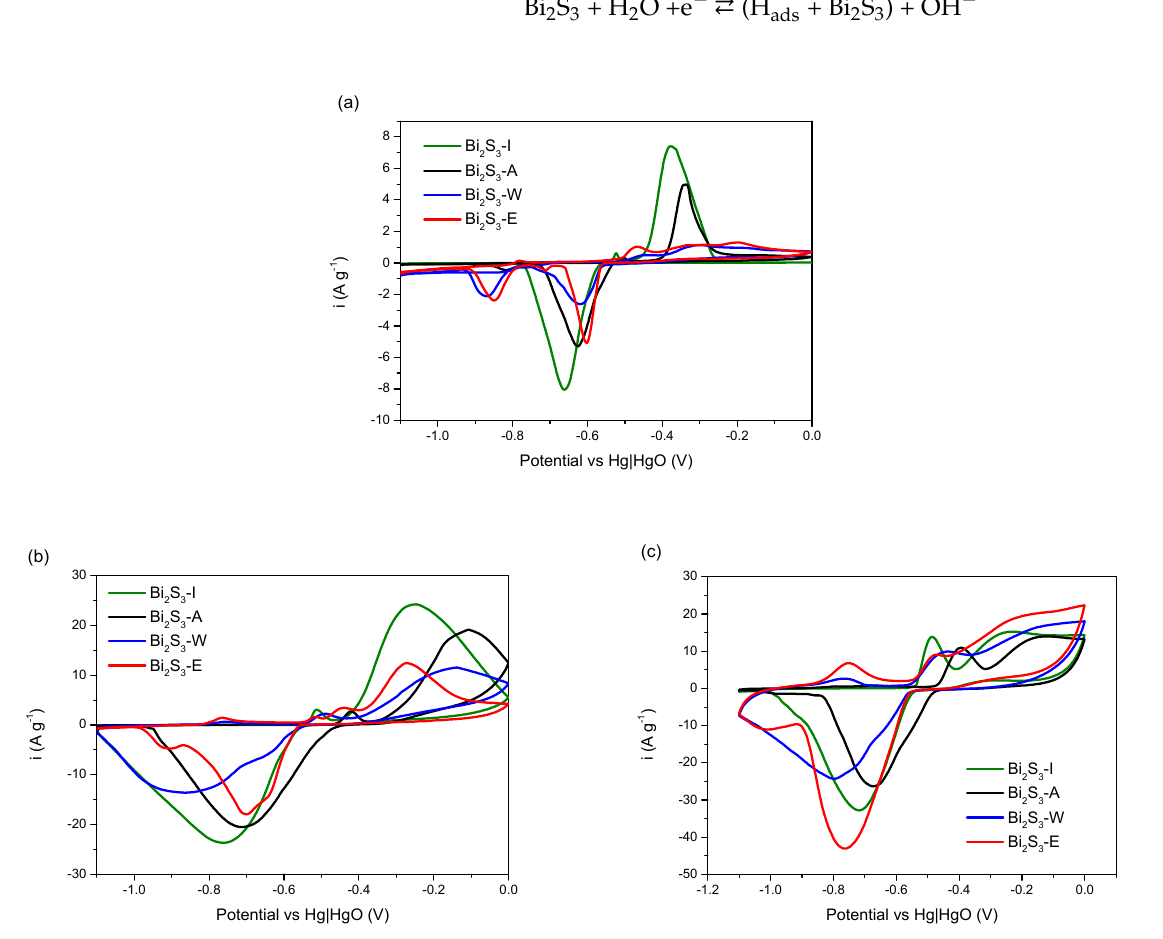
Figure 5. Cyclic voltammograms of the bismuth sulfides synthesized in different solvents at 1, 10, and 100 mV s − 1 ( a – c ). In accordance with the CV results, the GCD discharge curves of the Bi 2 S 3 electrodes (Figure 6a) show a distinct plateau at a potential of approximately − 0.6 V, indicating